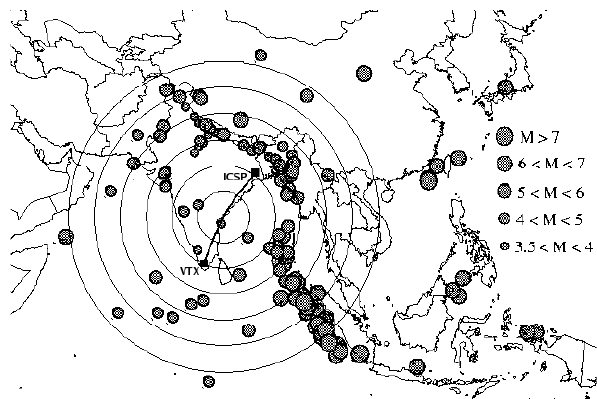
Fig. 1. Location of the earthquakes in relation to seismic circles centered around the first reflection point (FRP) of the VTX signal to ICSP, Kolkata, during the sixteen months under study. The locations of VTX and ICSP are marked with filled boxes and the FRP is marked with a filled circle. Shadowed circles represent the locations of the earthquakes, their sizes being proportional to the individual magnitudes. Concentric circles have radii of multiples of 500 km.